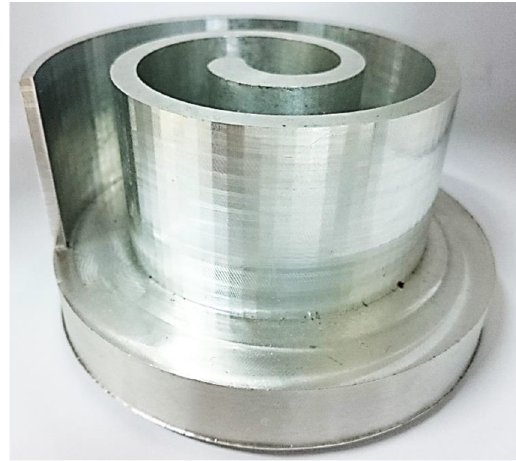
Figure 13. Scroll workpiece after the rough machining processes.